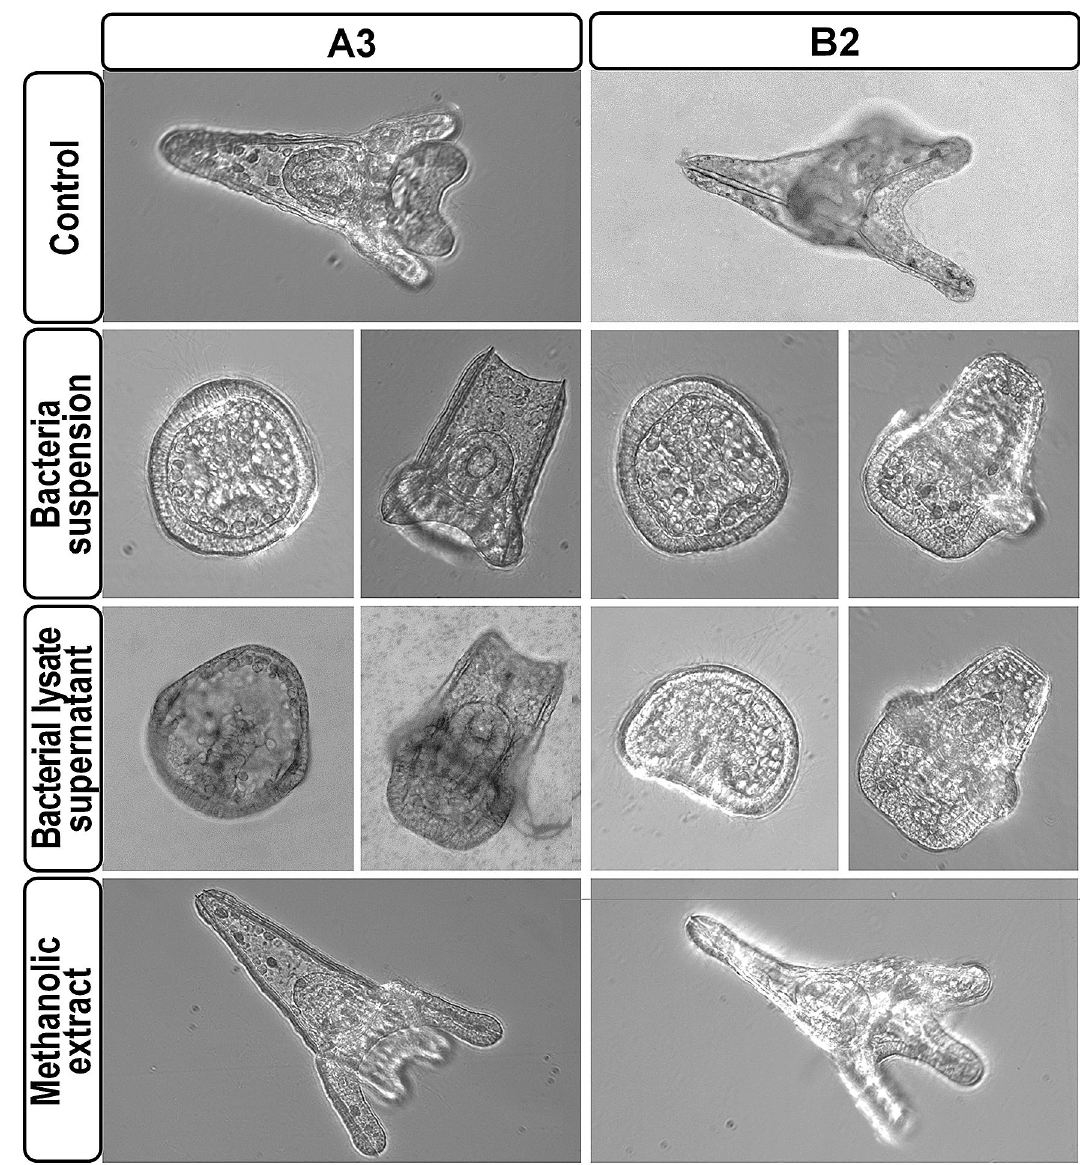
Figure 5. Developmental effects of coelomic fluid bacterial strain exposure on P. lividus . Representative embryos cultured in the absence (control) or in the presence of the indicated bacterial strains, bacterial lysate supernatants or equivalent amounts of methanolic extracts, and observed at the pluteus